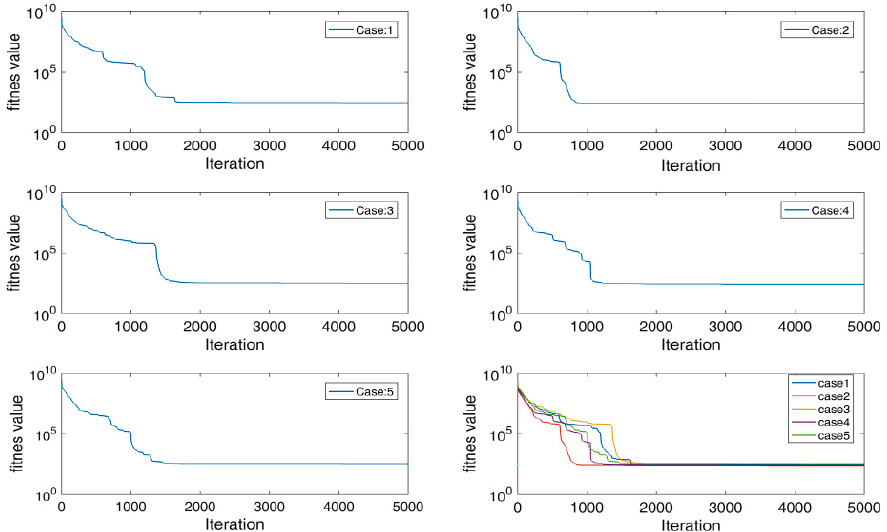
Figure 12. Convergence curves of TLBO in the case of the F ( X ) objective. Table 3. Load curve data for DSM cases1–5.